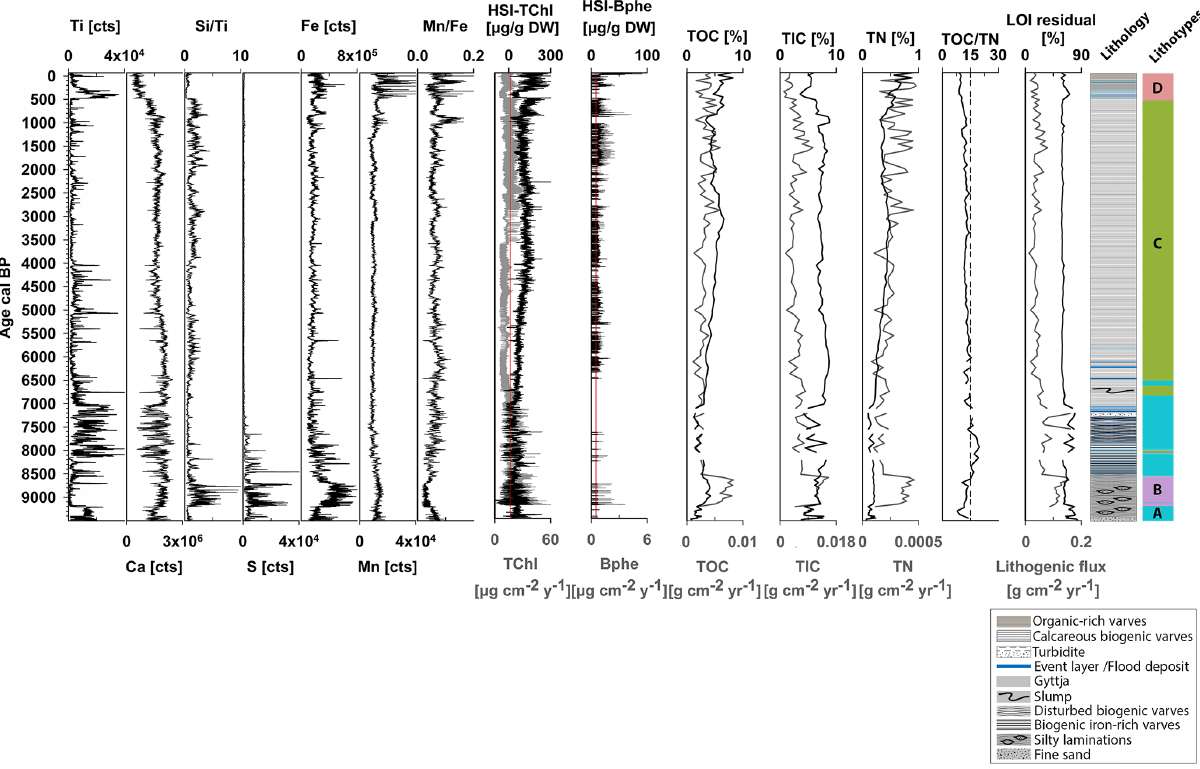
Figure 3. Selected biogeochemical proxies that defined the four sedimentary lithotypes A–D (in different colors) after unconstrained clus- tering and PCA (Fig. S2). On the right: sediment lithology based on visual examination.